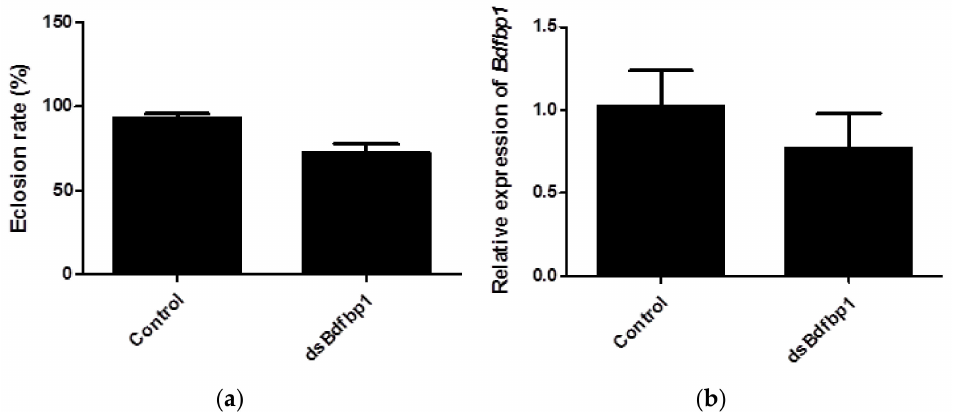
Figure 6. ( a ) The eclosion rate of B. dorsalis after RNAi treatment of larvae; ( b ) Bdfbp1 relative transcriptional expression in B. dorsalis late third instar larvae after RNAi treatment. Statistical analyses were performed using Student’s t test. The asterisk indicates significant difference ( p < 0.05). The standard deviation of each triplicate is shown by error bars in ( a , b